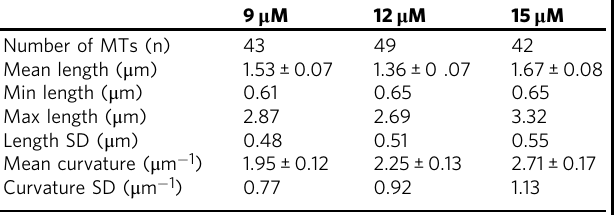
Values represent